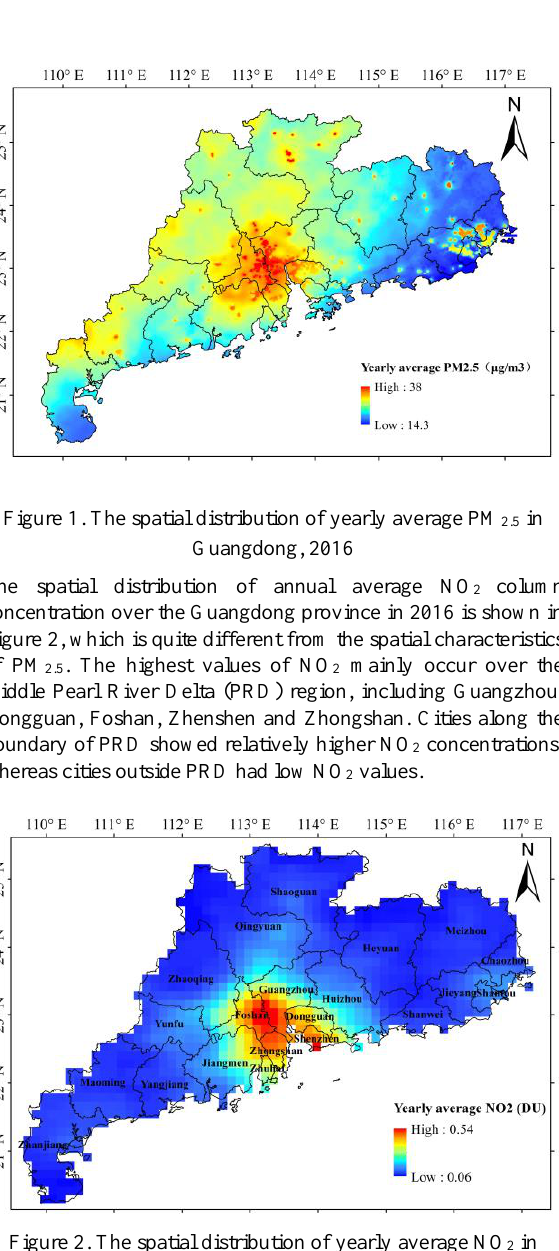
Figure 2. The spatial distribution of yearly average NO 2 in Guangdong,